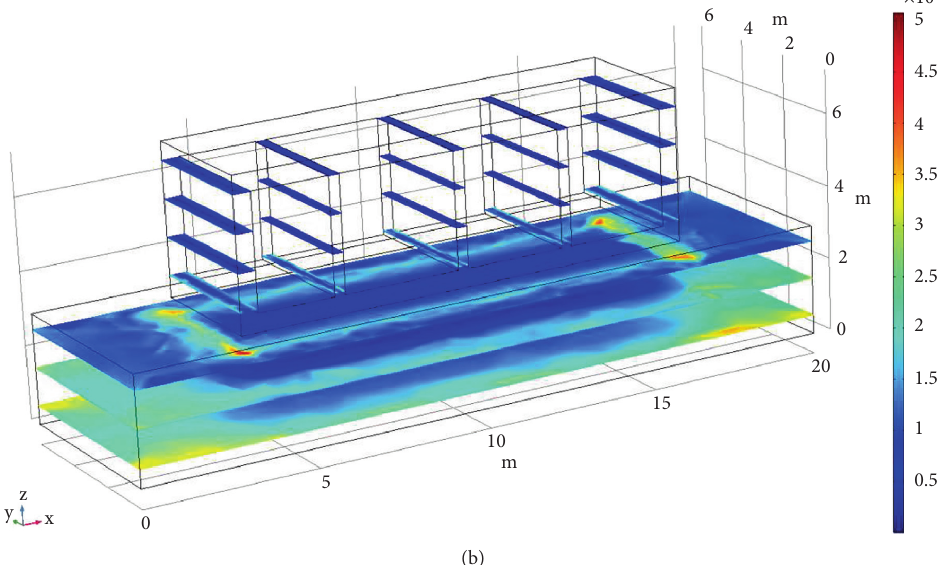
Figure 7: Stress distribution characteristics. (a) Overall view. (b) Slice